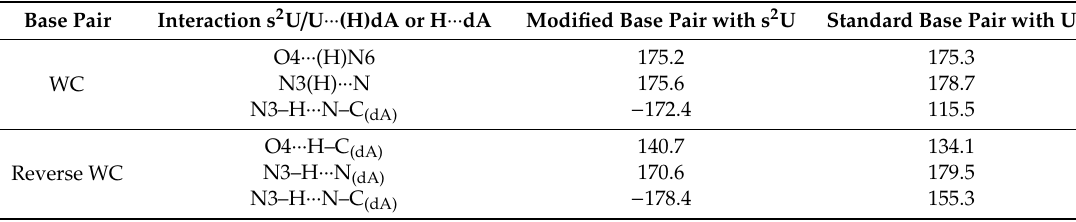
Table 5. Interatomic angles (in deg.) in the simulated base pairs with 2-thiouridine (s 2 U) or uridine (U) and 2 (cid:48) -deoxyadenosine (dA), at the B3LYP / 6-31G(d,p)